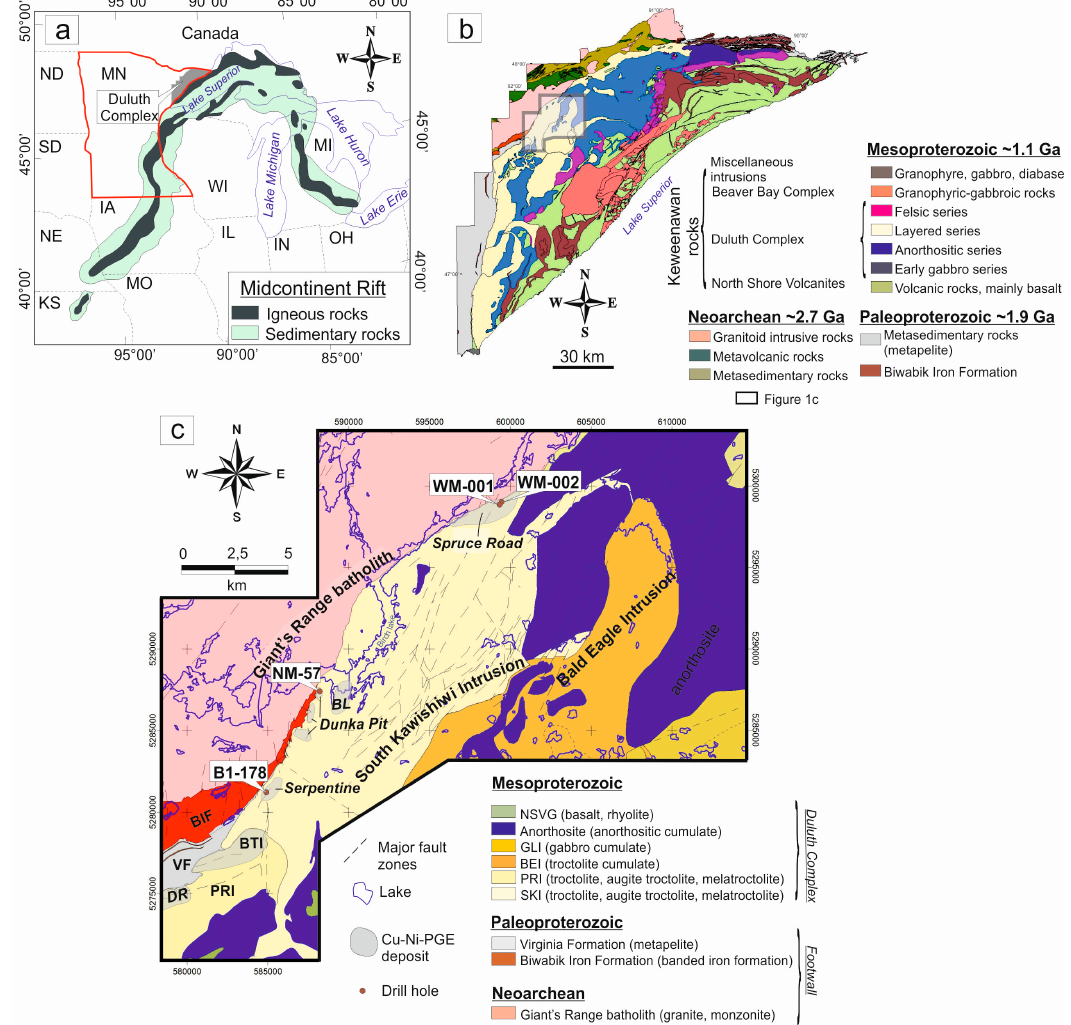
Figure 1. ( a ) The Midcontinent Rift system in North–America (significantly modified after [32]). ( b ) Geology of the Duluth Complex (the map is slightly modified after [30]). The South